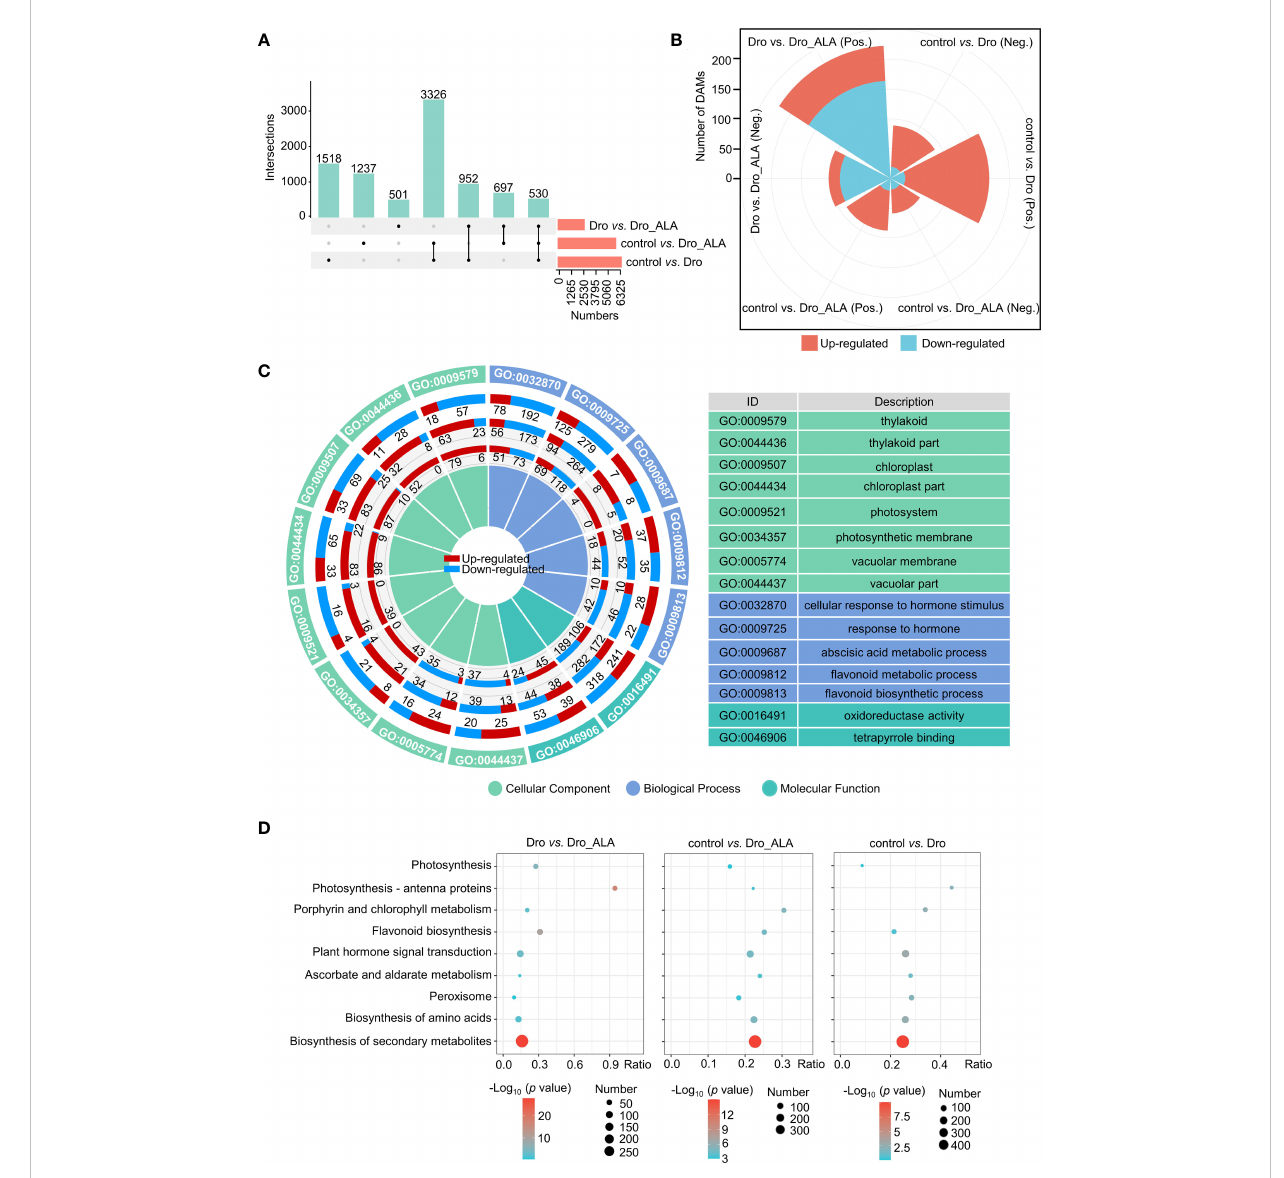
FIGURE 2 Functional annotations of total DEGs and DAMs. (A) Upset plot of DEGs between control and drought treatment (control vs. Dro); control and drought plus 5-aminolevulinic acid treatment (control vs. Dro_ALA); drought and drought and 5-aminolevulinic acid treatment (Dro vs. Dro_ALA). (B) Statistics of signi fi cant difference of DAMs between control vs. Dro, control vs. Dro_ALA, and Dro vs. Dro_ALA. The threshold of signi fi cant difference was VIP ≥ 1 and T-test P<0.05.(Pos. means positive and Neg. means negative) (C) Information about key GO terms of control vs. Dro, control vs. Dro_ALA, and Dro vs. Dro_ALA. The fi rst circle represents the GO ID, the second circle represents the DEGs between control vs. Dro, the third circle for control vs. Dro_ALA, and the fourth for Dro vs. Dro_ALA. Red and blue indicate up-regulated and down-regulated DEGs, respectively. (D) Information about key pathways in the KEGG enrichment pathways of control vs. Dro, control vs. Dro_ALA, and Dro vs.